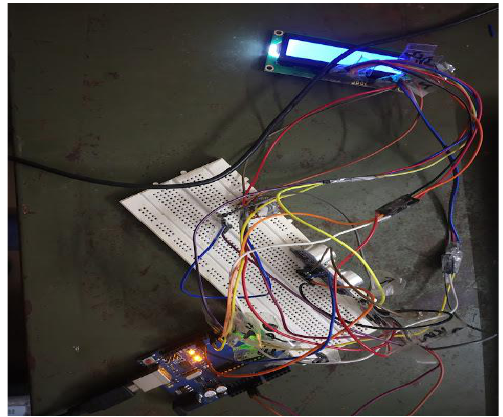
Figure 13. Implementation of the waste monitoring system.